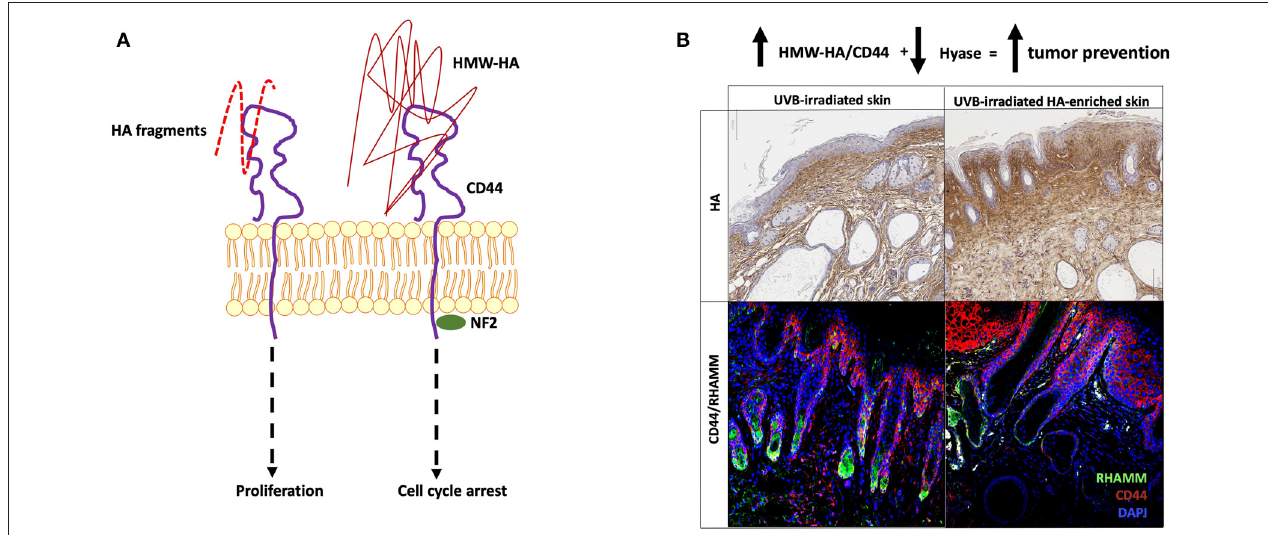
FIGURE 2 | HMW-HA functions in tumor prevention. (A) LMW-HA:CD44 interactions promote proliferation while HMW-HA:CD44 interactions suppress proliferation, which can be mediated by an association of CD44 with the tumor suppressor, Merlin (NF2). HMW-HA:CD44 signals result in cell cycle arrest and are one mechanism for reducing susceptibility to cancer. (B) Dorsal skin of UVB-exposed keratinocyte tumor-susceptible mice treated topically with HMW-hyaluronan-phosphatidylethanolamine (HA-enriched) do not form tumors, accumulate higher levels of HMW-HA (top panels) and CD44 (bottom panels), and lower levels of hyaluronidases than UVB-irradiated controls. Epidermal HA (brown) is detected via an HA-binding biotinylated protein on paraffin-embedded tissue counterstained with hematoxylin (blue). CD44 (red) and RHAMM (green) are detected using pan-antibodies in dorsal skin of mice counterstained with DAPI (blue).